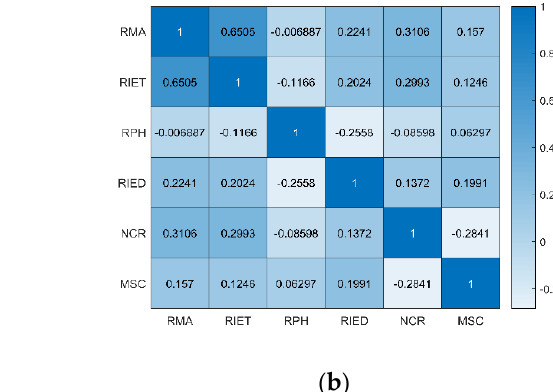
Figure 13. Characteristic correlation analysis of target and clutter. ( a ) characteristic correlation of target; ( b ) characteristic correlation of clutter.